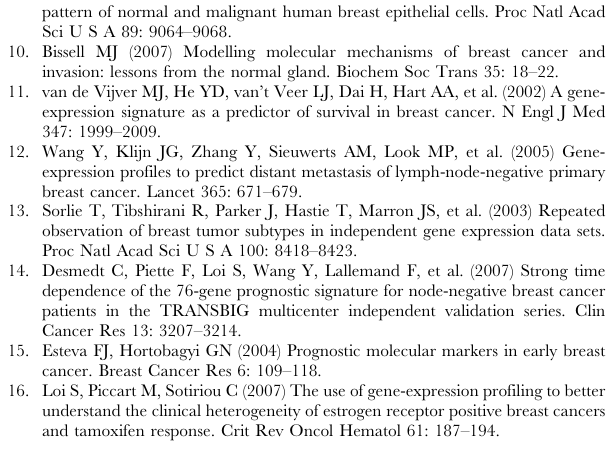
Figure S1 Kaplan-Meier curves of the individual genes that did not accurately predict patient prognosis (p . 0.05). A. Results for individual genes in the dataset of Wang, et al. using patient relapse as the endpoint. B. Results for individual genes in the dataset of Sorlie, et al. using patient survival as the